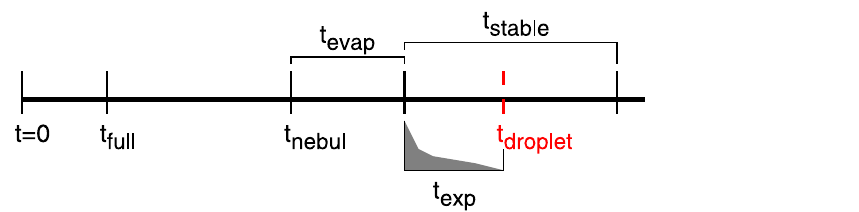
Fig 1. Nebulization process. Time line for nebulization and suitable time interval for the experiments ( t exp , represented in grey). The beginning of t exp is the most convenient time frame for measurements.